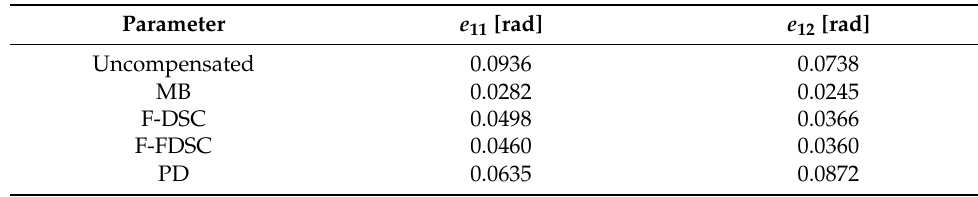
Table 2. Output error